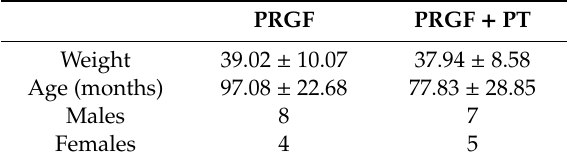
PRGF: Plasma rich in growth factors; PT: Physical